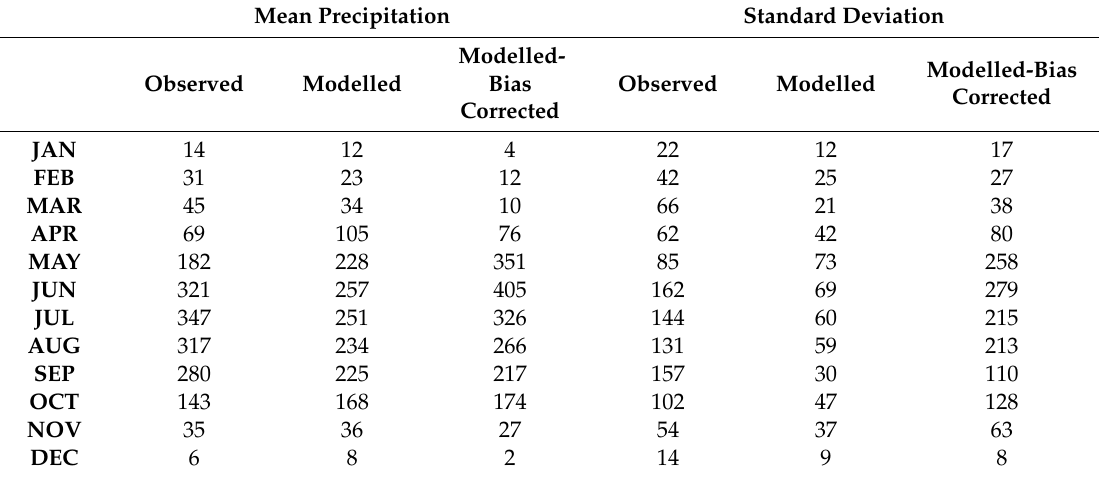
Table A1. Comparison of observed and SEAS5 monthly mean precipitation and standard deviation (in mm) for Khulna station.